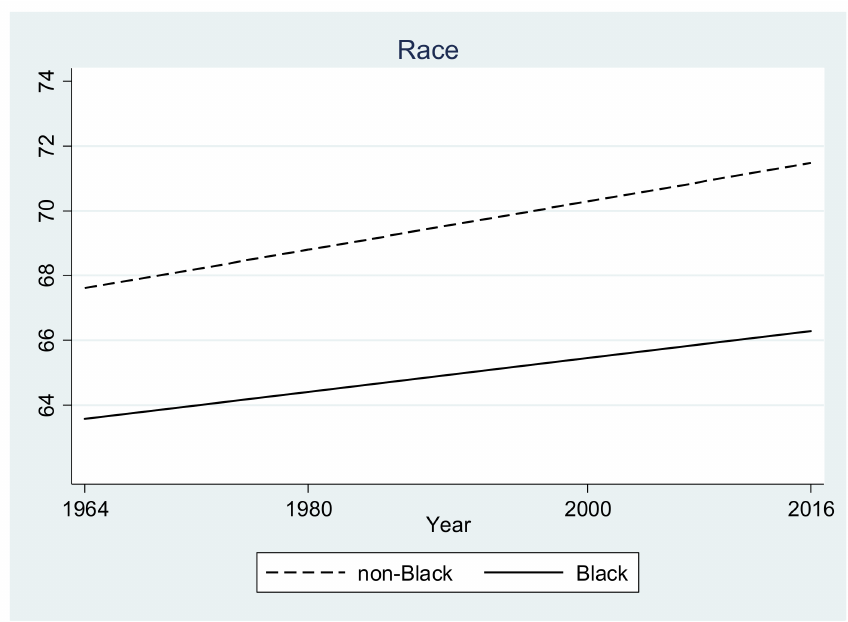
Figure 2. Impact of race on the Jewish feeling thermometer, 1964–2016. Based on results from Table 3. Source: American National Election Studies,